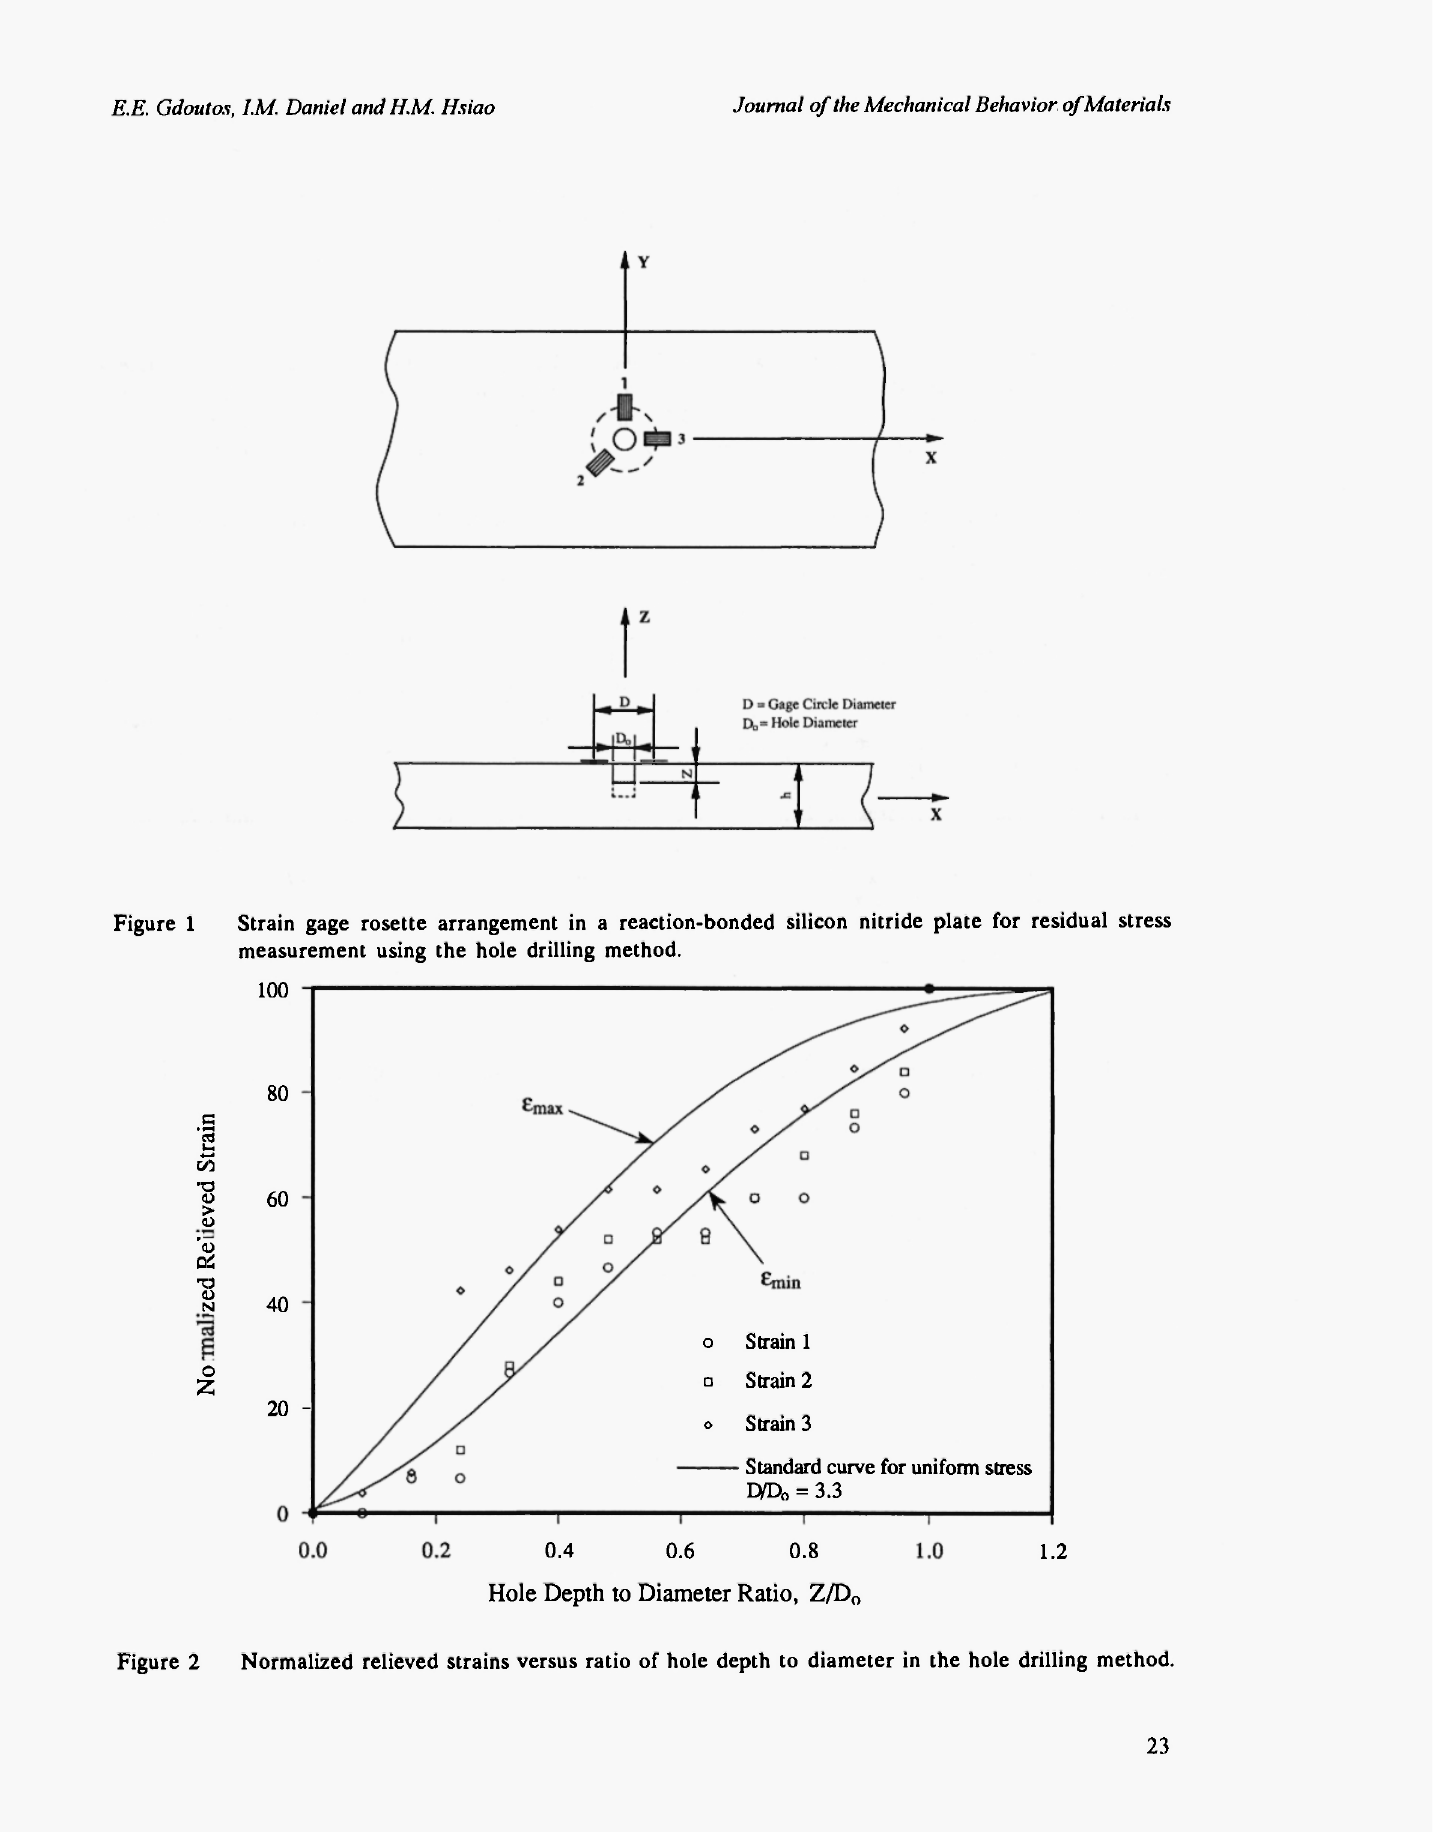
Figure 2 Normalized relieved strains versus ratio of hole depth to diameter in the hole drilling